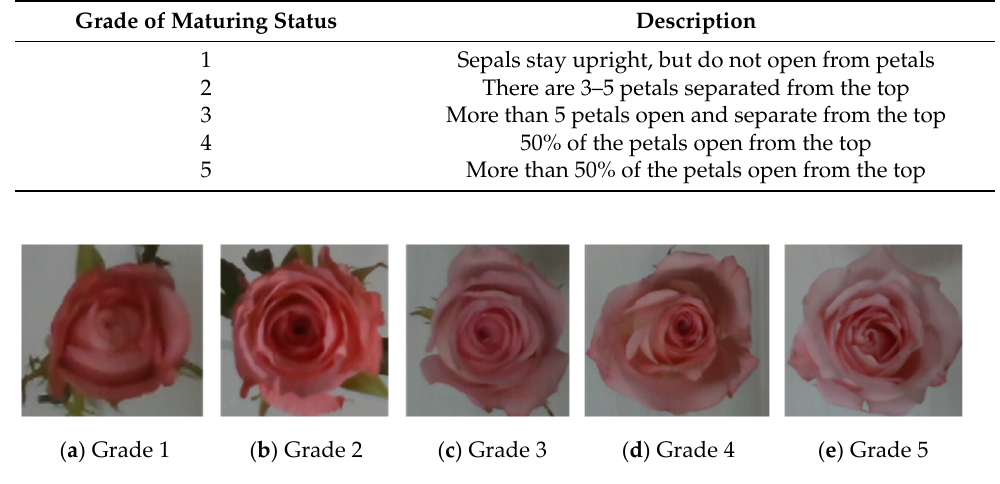
Figure 1. Images of flowers of different maturing status.